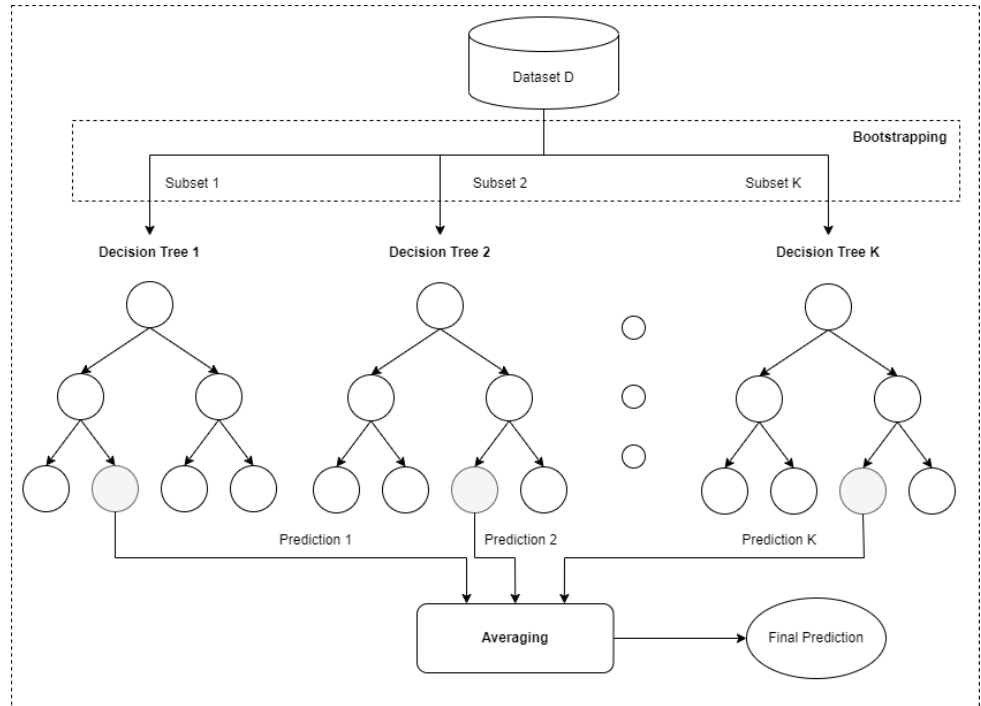
Figure 1. The structure of the random forest algorithm, which is based on bootstrap aggregating (or bagging) the predictions of multiple decision tree